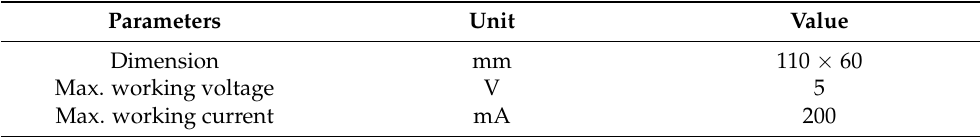
Table 2. The manufacturer’s specification of the photovoltaic panel.